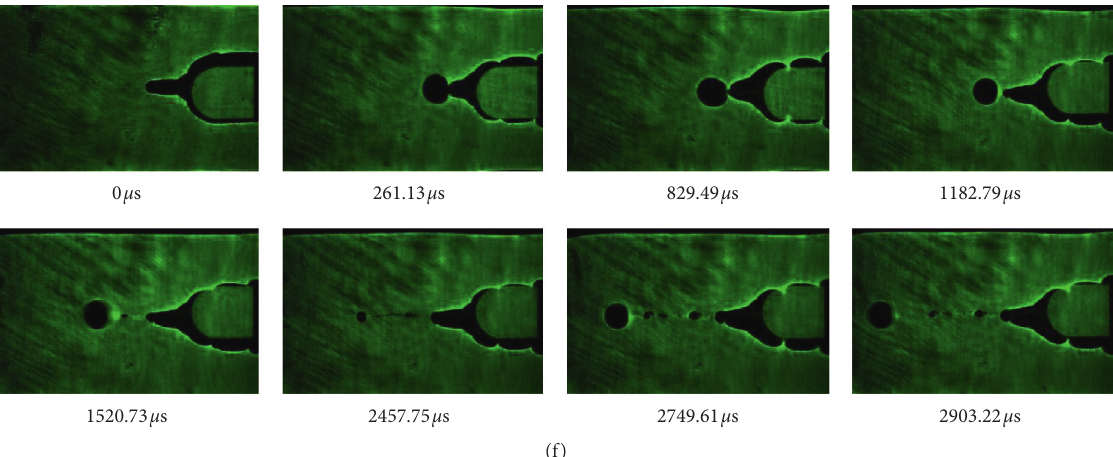
Figure 8: Dynamic caustic image patterns on the tunnel model specimen under different impact speed conditions. (a) V � 3.32m/s. (b) V � 3.78m/s. (c) V � 4.28m/s. (d) V � 4.53m/s. (e) V � 4.79m/s. (f) V �